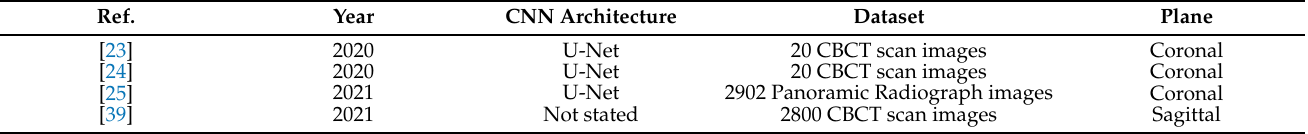
Table 1. Works related to periapical lesion classification with the use of CNN.